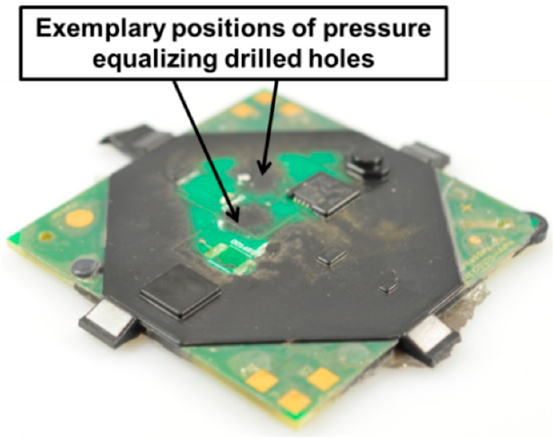
Figure 13. Pressure equalizing holes were also not useful in avoiding the PCB from bending during mold trials MT02.